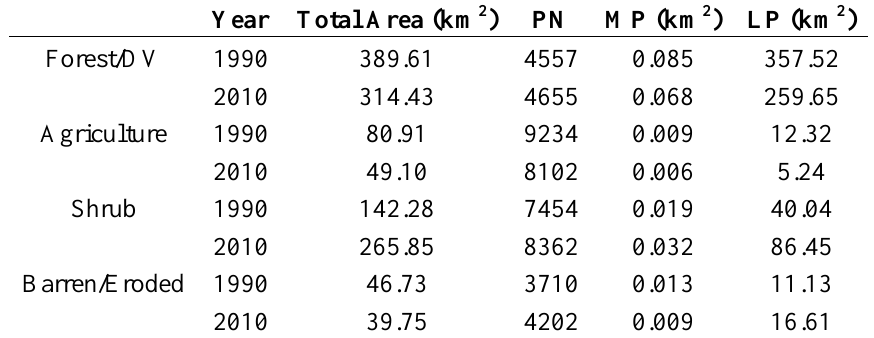
Table 4. Landscape pattern metrics/indices for the years 1990 and 2010 (PN = patch number, MP = mean patch area, LP = largest patch size).